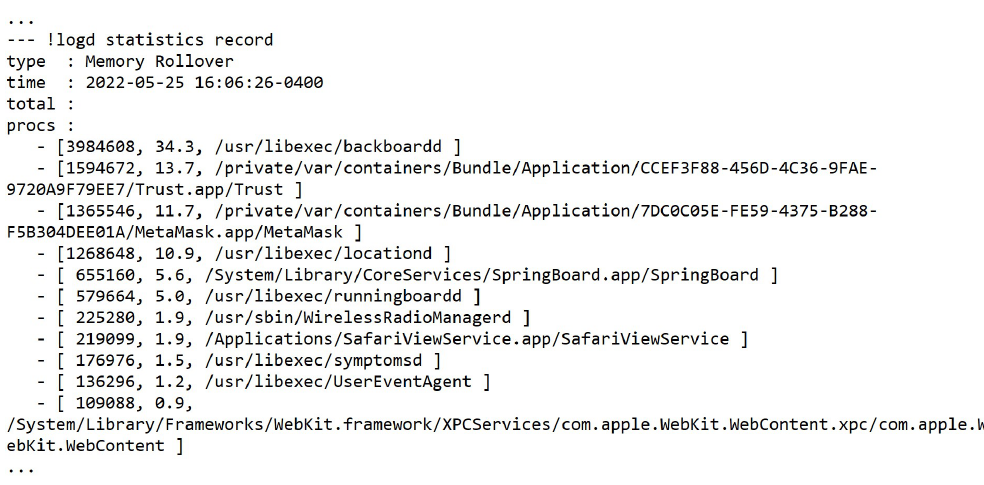
Figure 36. Example of a memory rollover recovered from